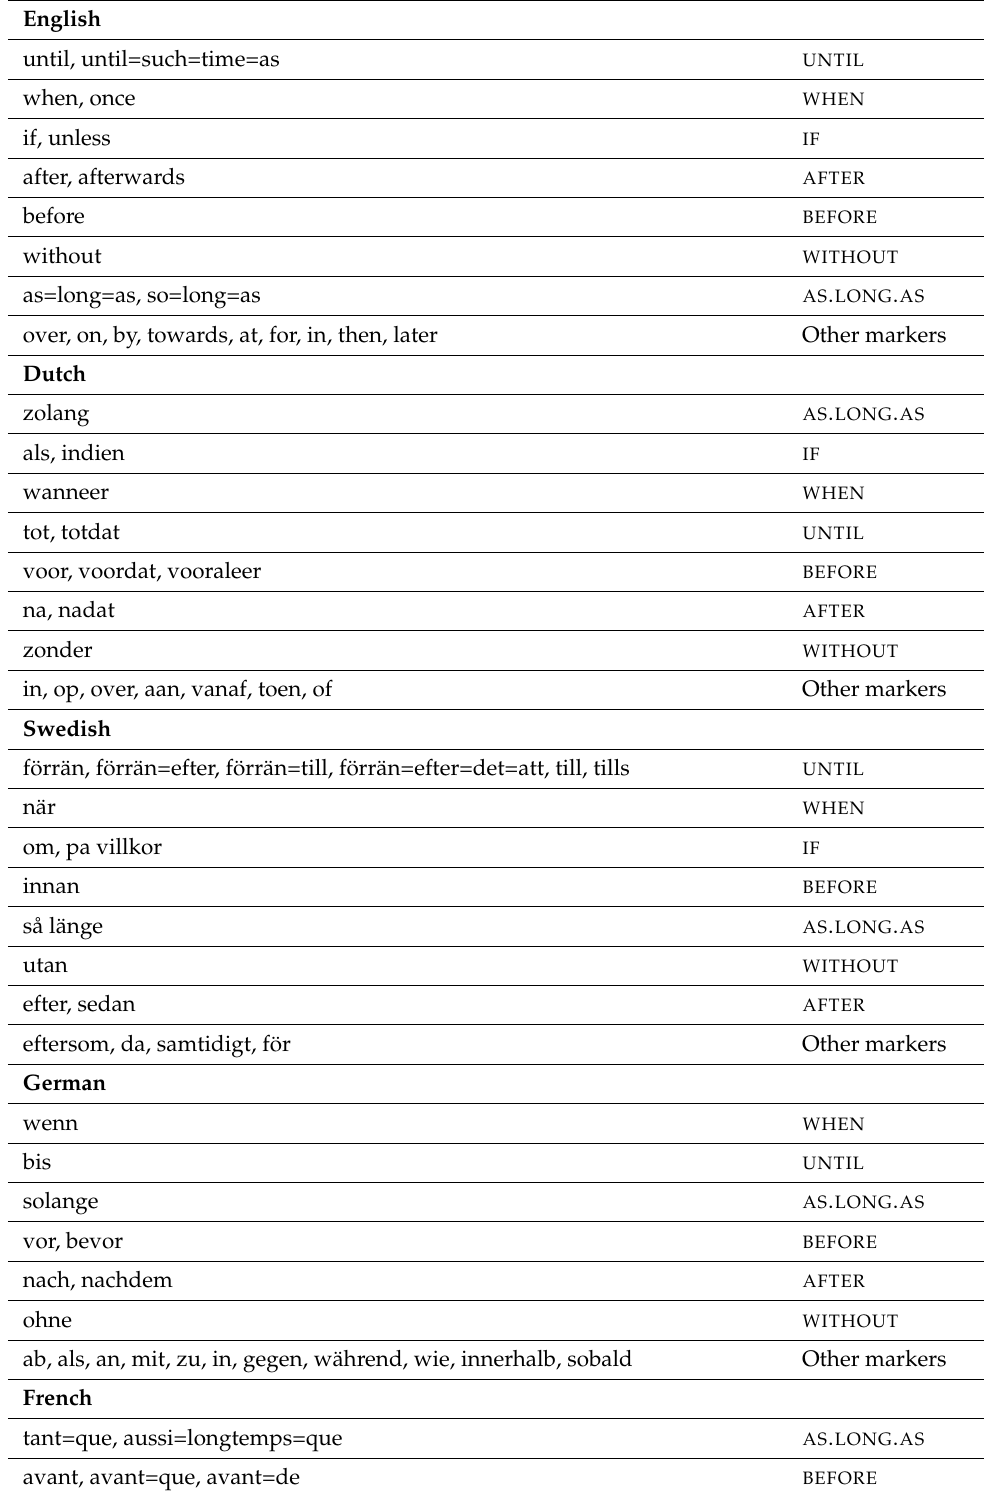
Table A1. List of attested